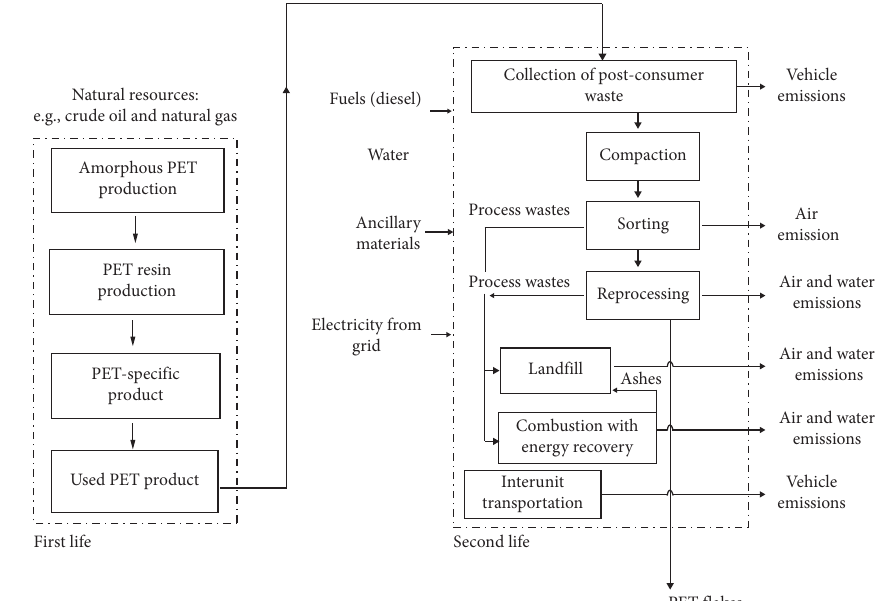
Figure 1: Life cycle recycling PET from waste PET, splitting the first life and the second life based on the “cut-off”